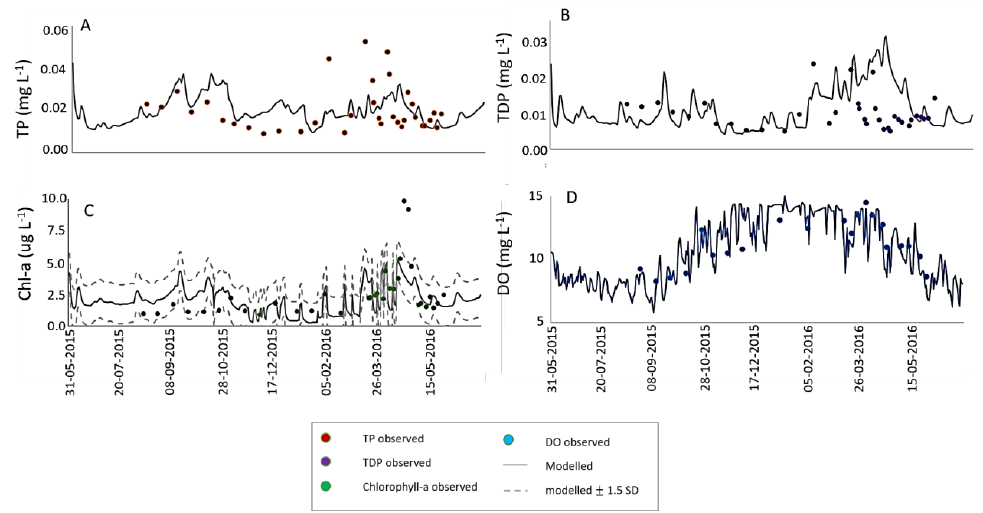
Figure 2. Calibration results of ( A ) TP concentration ( B ) TDP concentration, ( C ) chl-a concentration and ( D ) DO concentration within the river mouth of the Beaver River catchment between 2015 and 2017.